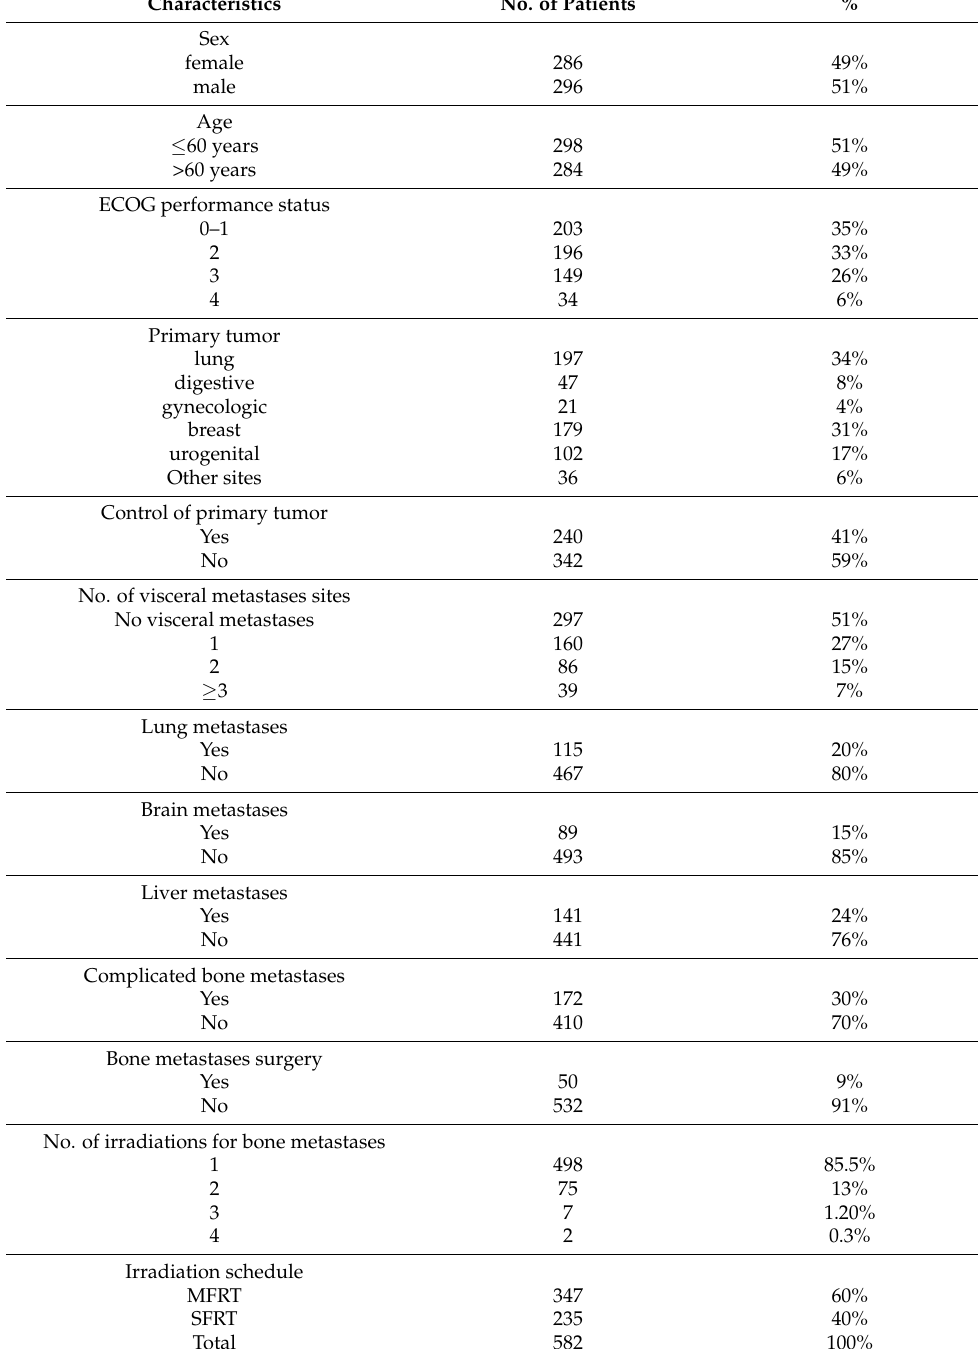
Table 1. Clinical characteristics of